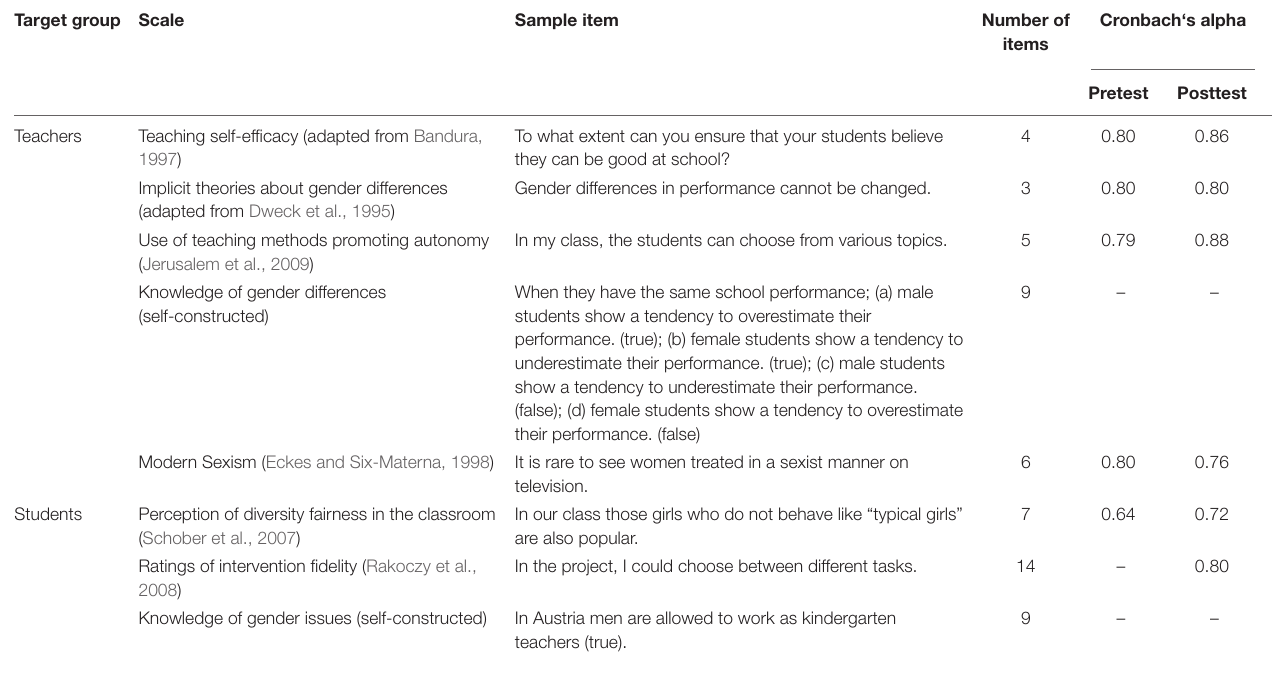
TABLE 1 | Sample items and reliabilities of the questionnaires used in the evaluation of REFLECT. Target group